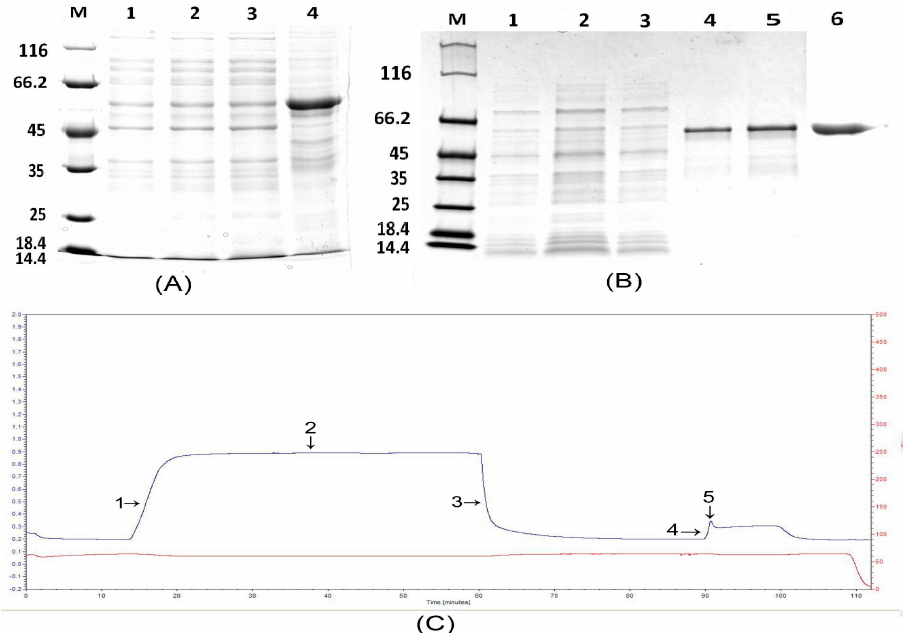
Figure 5. The process of denaturation and purification of the Pt4CL-like protein. ( A ) The denaturation process of Pt4CL-like protein. Lane M: molecular mass marker; lane 1: denaturation with 2 M urea; lane 2: denaturation with 4 M urea; lane 3: denaturation with 6 M urea; lane 4: denaturation with 8 M urea; ( B ) Purification of the Pt4CL-like fusion protein. Lane M: molecular weight marker; lane 1–2: flow-through; lane 3: wash; lane 4–5: elution; lane 6: Western blotting analyses of purified Pt4CL-like fusion protein using a mAb against the His6 tag. ( C ) Ni-IDA affinity chromatography of the fusion protein carried out using LP Data View software (Biologic LP, Bio-rad, Hercules, USA).